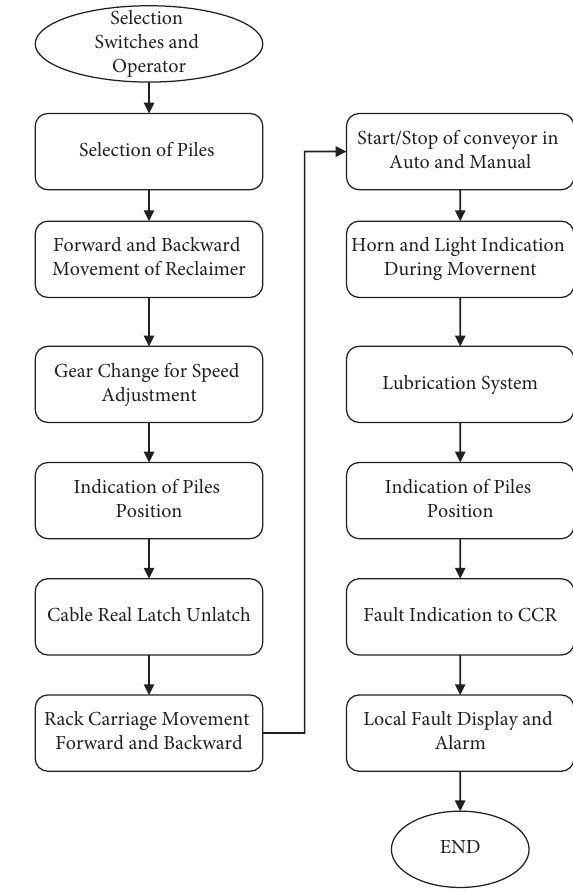
Figure 2: Schematic graph of investigation